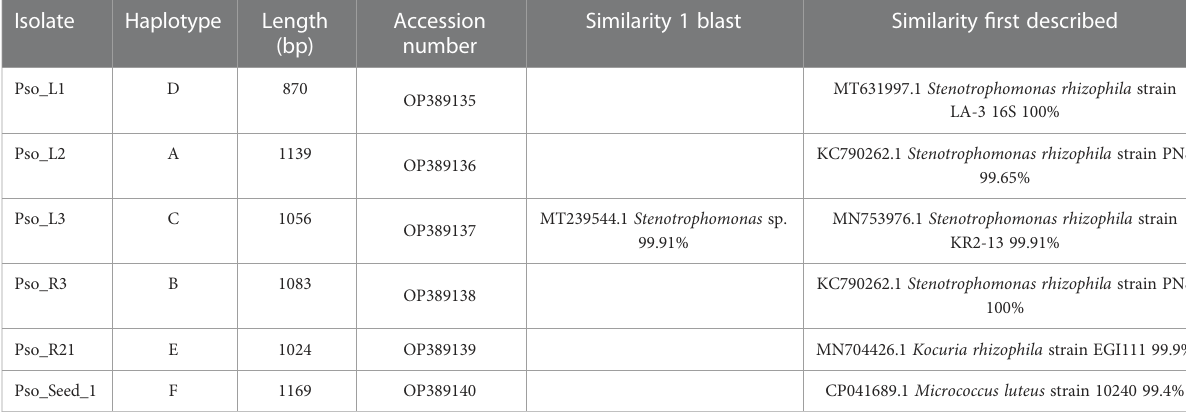
TABLE 3 Taxonomic af fi liation of the bacterial isolates according to BLAST analysis.